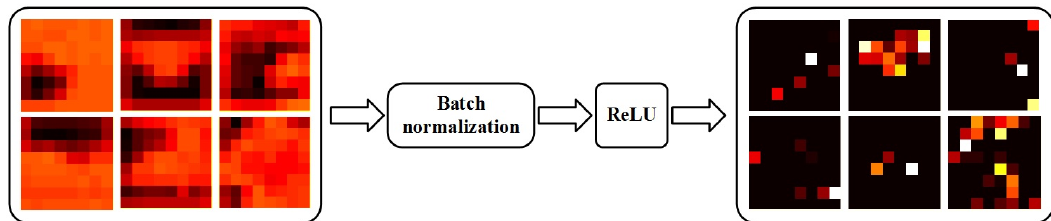
Figure 4. Sketch map of feature extraction by batch normalization (BN) and rectified linear unit (ReLU). The combined operator will extract the most active features from previous feature-maps, which makes the convolution layer more efficient, but also makes the feature-map sparse.